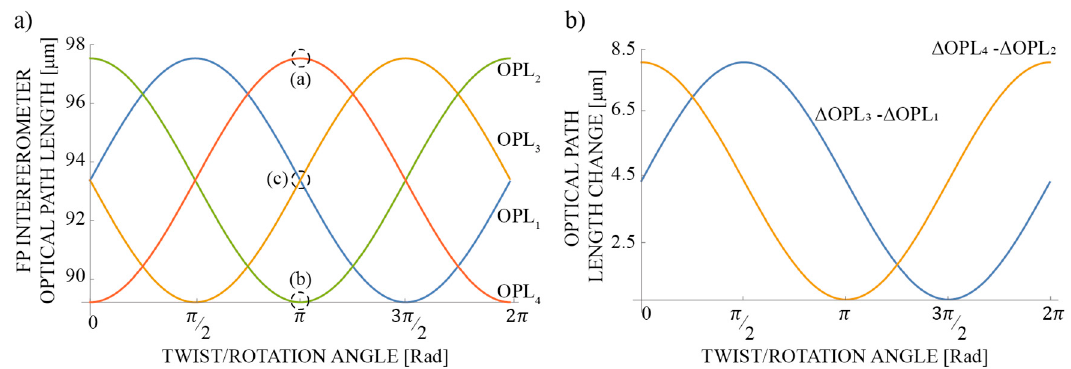
Figure 5. ( a ) Optical path length change of all FP-Interferometers (from Equation (5)) when the sensor is rotated by a “mechanical” angle 0 ≤ Φ ≤ 2 π . Physical parameters for the sensor in the simulation: d = 70.7 μ m, δ p = 15°, n 1 = 1, n 2 = 1.444 and ( b ) Subtracted path length variations of diametrically positioned FP-Interferometers (N = 1 – N = 3 and N = 2 – N = 4).